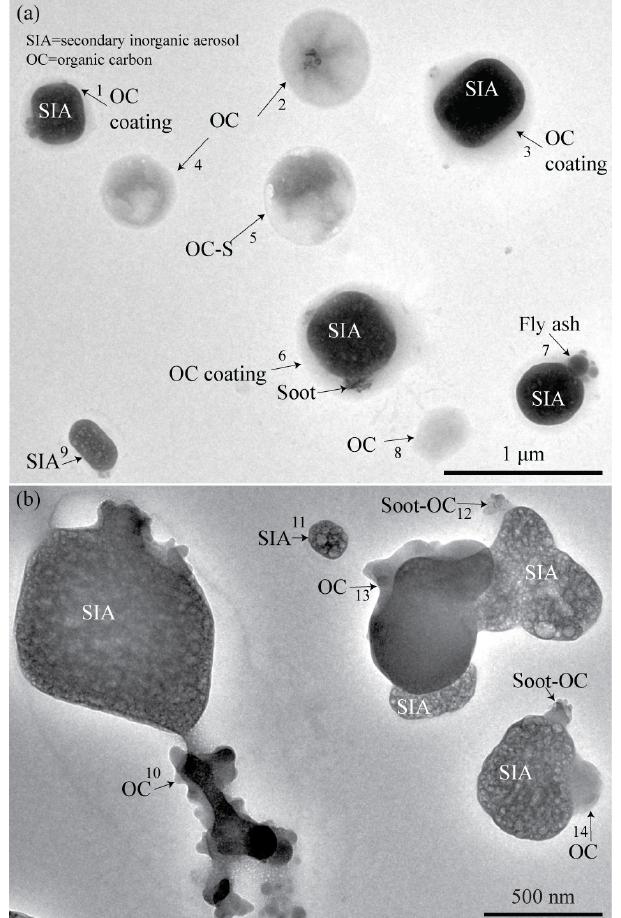
Figure 9. Individual particles during biomass burning periods with PM 2 . 5 mass concentration larger than 30µgm − 3 . (a) OC and SIA– soot–OC coating particles on 12 October. (b) SIA-soot-visible OC on 19 October. OC in particles 1, 3, 6, 10, 13, and 14 are heteroge- neously mixed with SIA particles and particles 2, 4, 5, and 8 homo- geneously mixed with minor SIA.